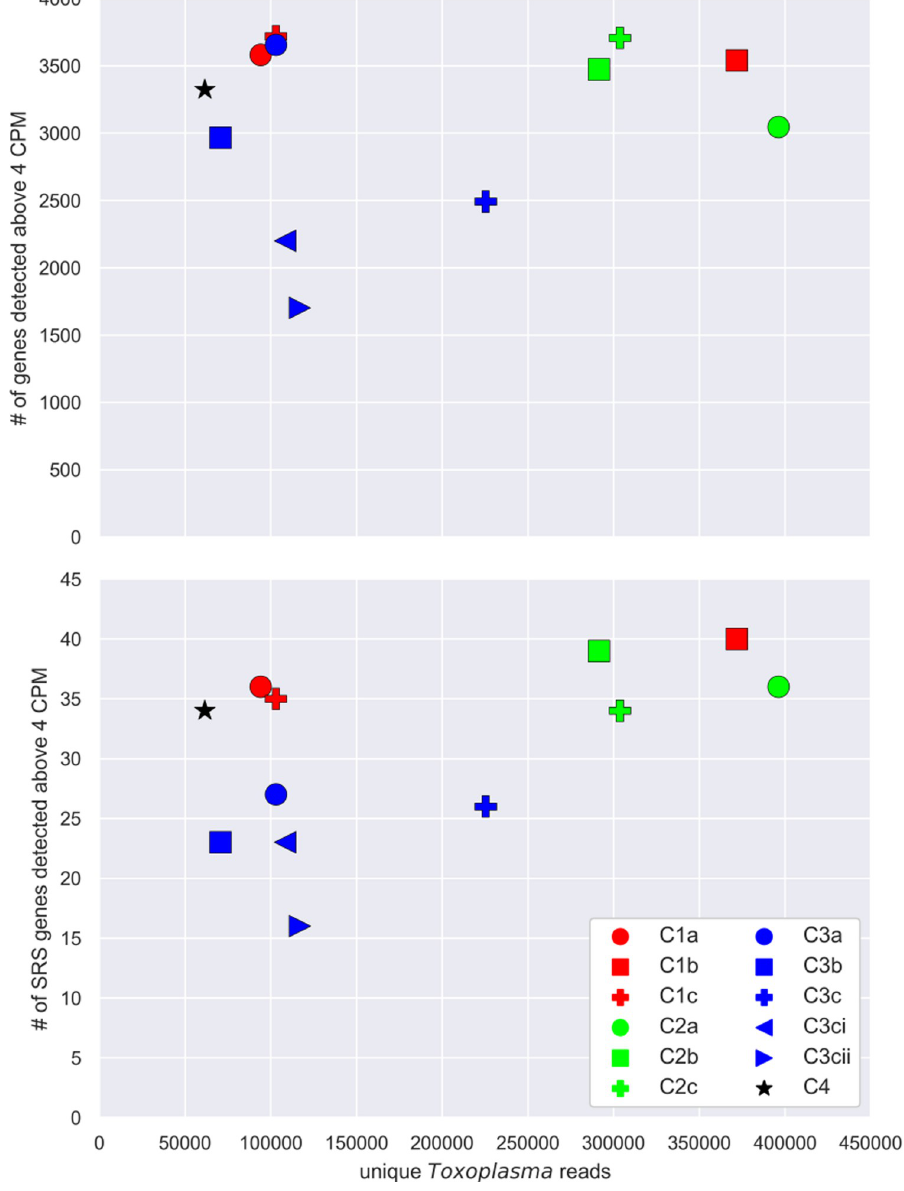
Fig 3. Toxoplasma transcript detection and read depth. For each sample, the total number of Toxoplasma genes “detected” in that sample is plotted against the total number of reads that uniquely aligned to the Toxoplasma genome in that sample (top panel). A gene was considered “detected” if it was above 4 counts per median (CPM; see Materials and Methods). C3ci and C3cii represent the results from the RNA sample that was split prior to cDNA synthesis. C3c represents the aggregation of the C3ci and C3cii data. Bottom panel is the same analysis as the top panel except only reads mapping to the 111 annotated SRS genes were counted for plotting on the y-axis. 33 and 40 SRS genes were detected (Fig 3 bottom). The C3 subclones had substantially lower counts of detected SRS genes ranging from 23 to 27 (using the pooled “C3c” data for C3ci and C3cii). The r 2 value of the linear regression using the SRS detection vs. total Toxoplasma reads (Fig 3) is higher (0.288) than the r 2 for the same analysis using the total genes detected (0.05; Fig 3). The lower number of SRS genes detected in the C3a and C3b subclones is not a